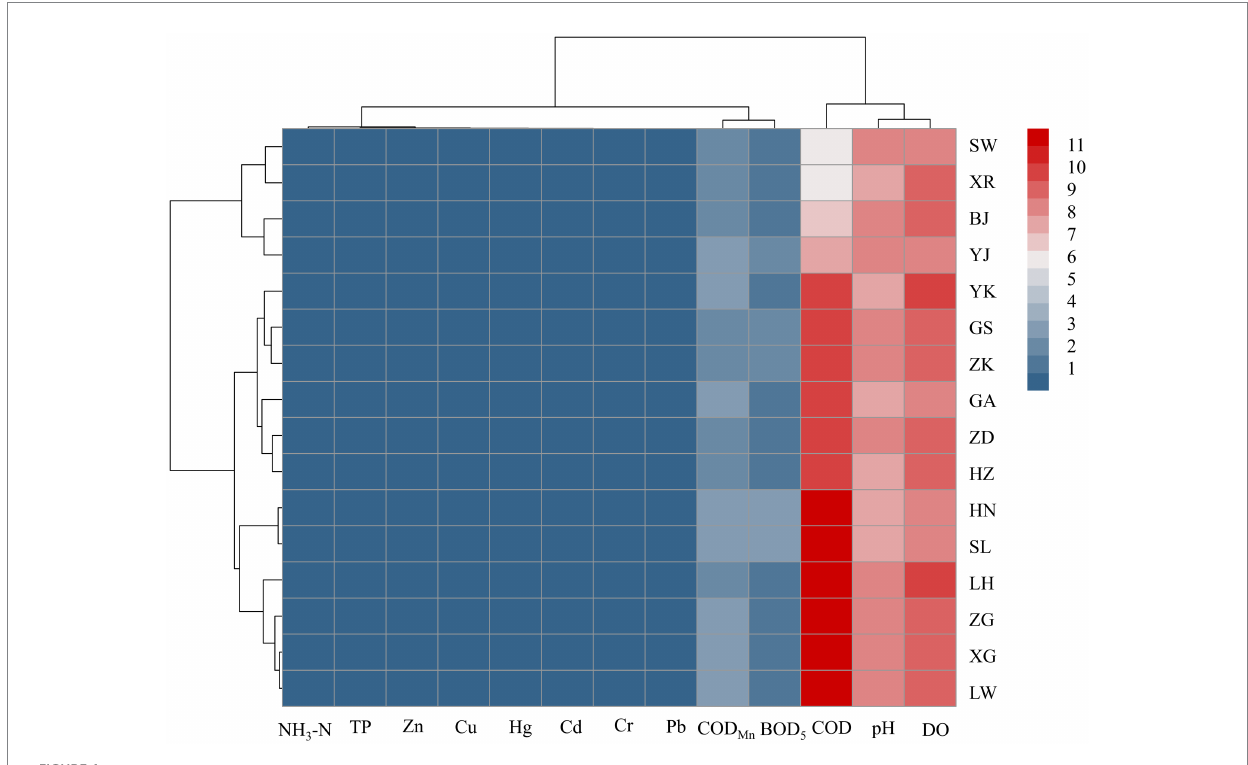
FIGURE 4 Cluster analysis results of water quality indicators and sampling